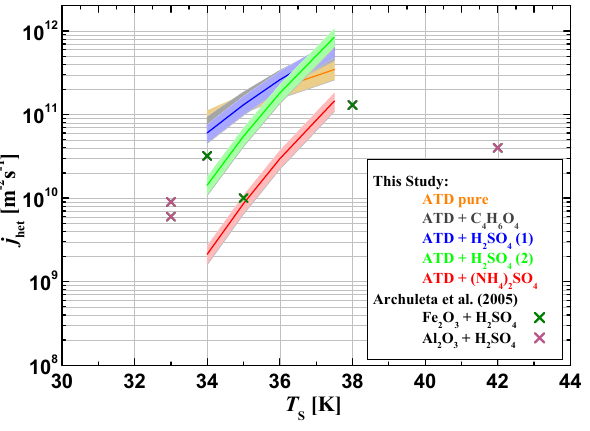
Fig. 11. Derived values for n s (T ) from the measurements (us- ing Eq. 11) as well as curves resulting from parameterization (see Eq. 12) as function of temperature [ ◦